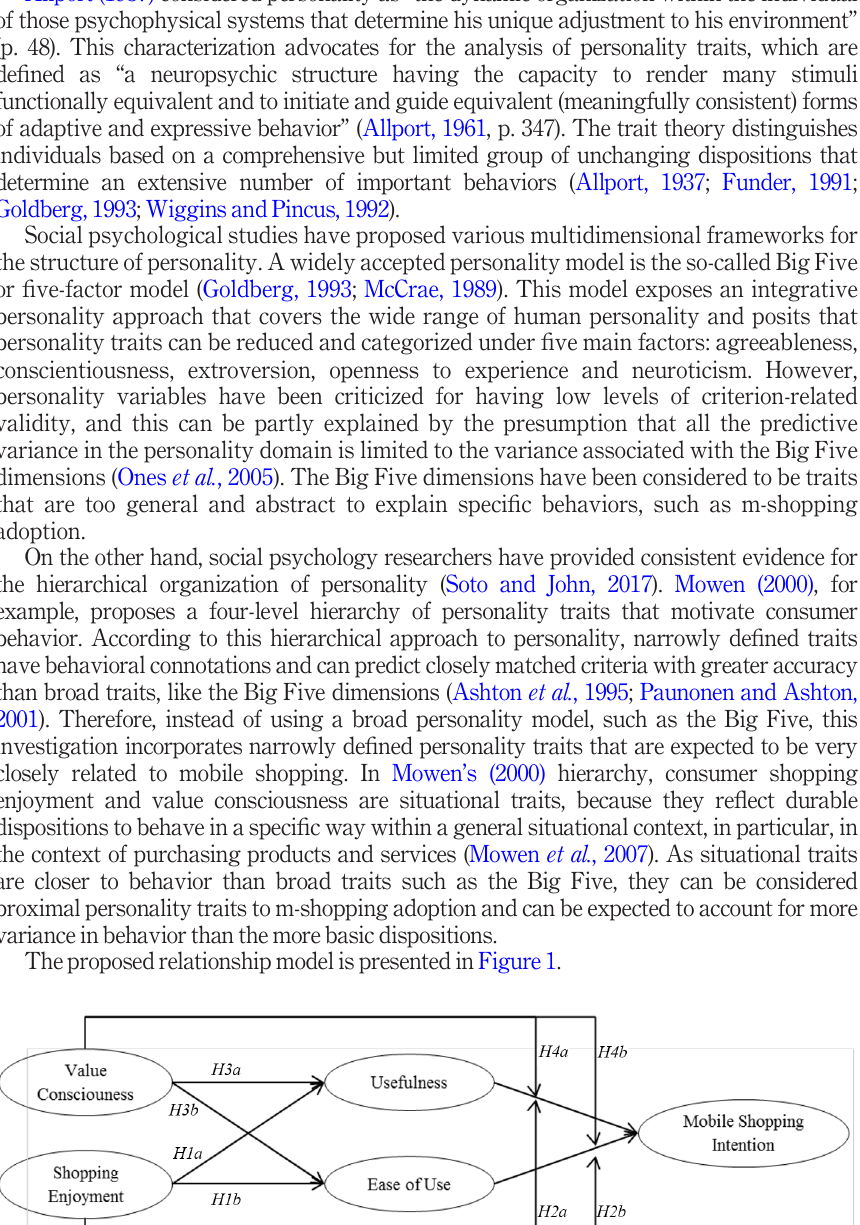
Figure 1. Research